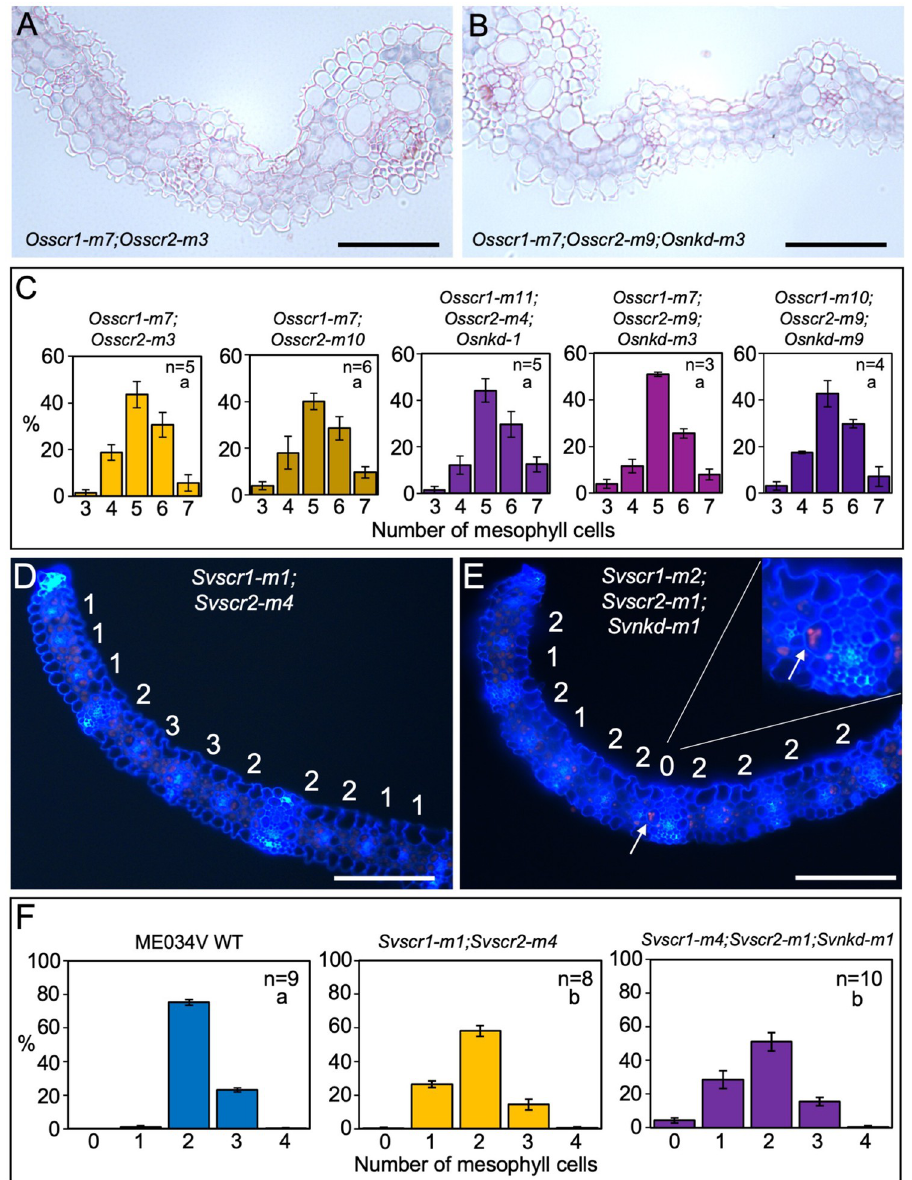
Fig 6. Loss of function nkd mutations induce the formation of fused leaf veins in scr mutants of setaria but not rice. A-B) Transverse sections of Osscr1-m7;Osscr2-m3 (A) and Osscr1-m7;Osscr2-m9;Osnkd-m3 (B) mutant leaves, taken at the midpoint along the proximal-distal axis of leaf 5. C) Histograms summarizing the mean number of mesophyll cells separating veins in two independent Osscr1;Osscr2 (yellow) and three independent Osscr1;Osscr2; Osnkd (purple) mutant lines. Error bars are standard error of the mean (raw data in S1 Table). Sample sizes (n =) are biological replicates. D-E) Transverse sections of Svscr1-m1;Svscr2-m4 (D) and Svscr1-m2;Svscr2-m1;Svnkd-m1 (E) mutant leaves, taken at the midpoint along the proximal-distal axis of leaf 4, imaged under UV illumination. The number of mesophyll cells separating veins is displayed above each region. In (E) white arrows and the inset show an example of a fused vein with no separating mesophyll cells. F) Histograms summarizing the mean number of mesophyll cells separating veins in wild-type (WT) ME034V (blue), Svscr1-m1;Svscr2-m4 (yellow) and Svscr1-m4; Svscr2-m1;Svnkd-m1 (purple) mutants. Error bars are standard error of the mean. Sample sizes (n =) are biological replicates and letters in the top right corner (beneath sample sizes) of each plot indicate statistically different groups ( P � 0.05, one-way ANOVA and Tukey’s HSD) calculated using the mean number of mesophyll cells in each genotype (raw data in S1 Table). Scale bars: 100 μ m.